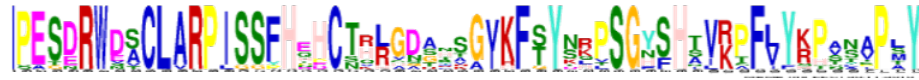
Figure 8. The most conserved PAC domains from clade C. The comparisons have been made between 18 PAC domain sequences from Lycopodiales to Brassicales.